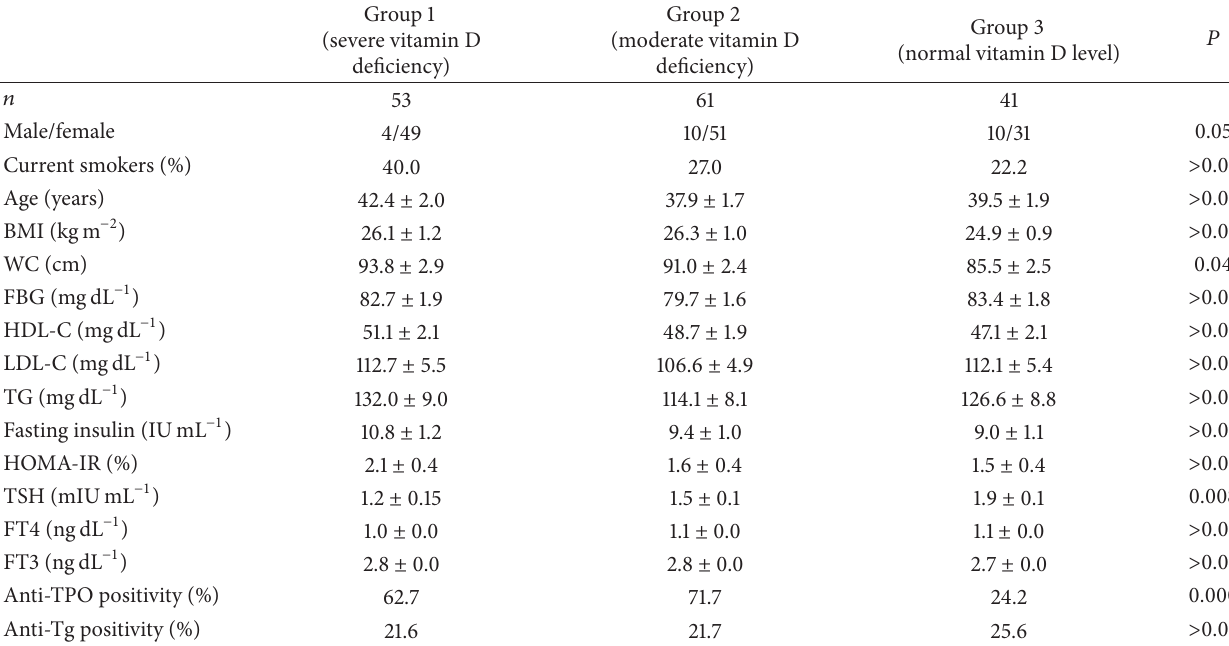
Table 1: Clinical characteristics of the participants according to group.